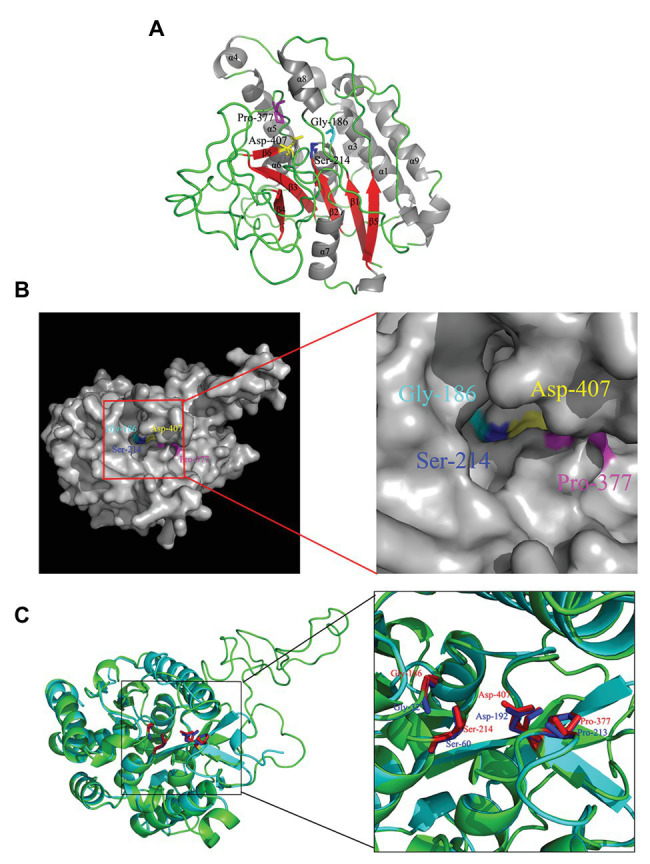
3-D model of Rv3091 protein. (A) 3-D structural modeling of Rv3091 reveals α/β hydrolase folds. The α helices are indicated in gray, β-strands in red, and loops in green. The conserved residue Gly186 is shown with cyan sticks, Ser214 is shown in blue sticks, Pro377 is shown in magenta sticks, and Asp407 is indicated as yellow sticks. (B) The surface representation of Rv3091. The conserved residue Gly186 is shown in cyan sticks, Ser214 is shown in blue sticks, Pro377 is shown in magenta sticks, and Asp407 is indicated in yellow sticks. It is noteworthy that the conserved residues formed a pocket surface structure. (C) Three-dimensional (3-D) structural alignment of Rv3091 and PlpD. The active site residues are shown in different colors in the 3-D structural model of Rv3091 and P. aeruginosa PlpD (red and blue, respectively).